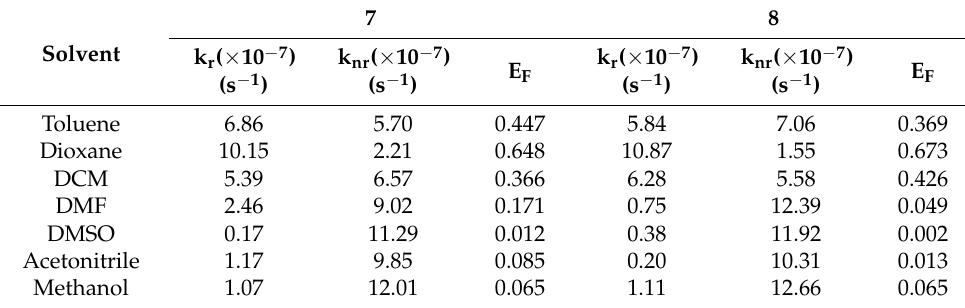
Table 2. Photophysical data of piperidine-naphthalimides in different